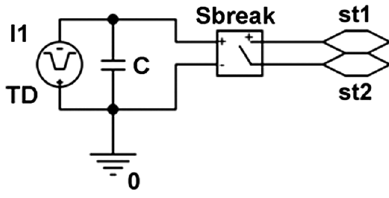
and minimal U max min